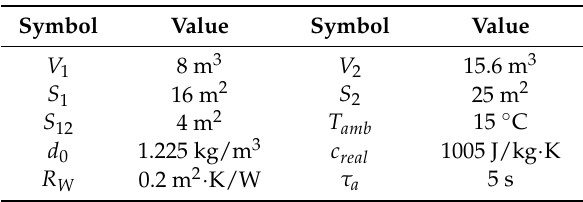
Table 1. Parameters definition.